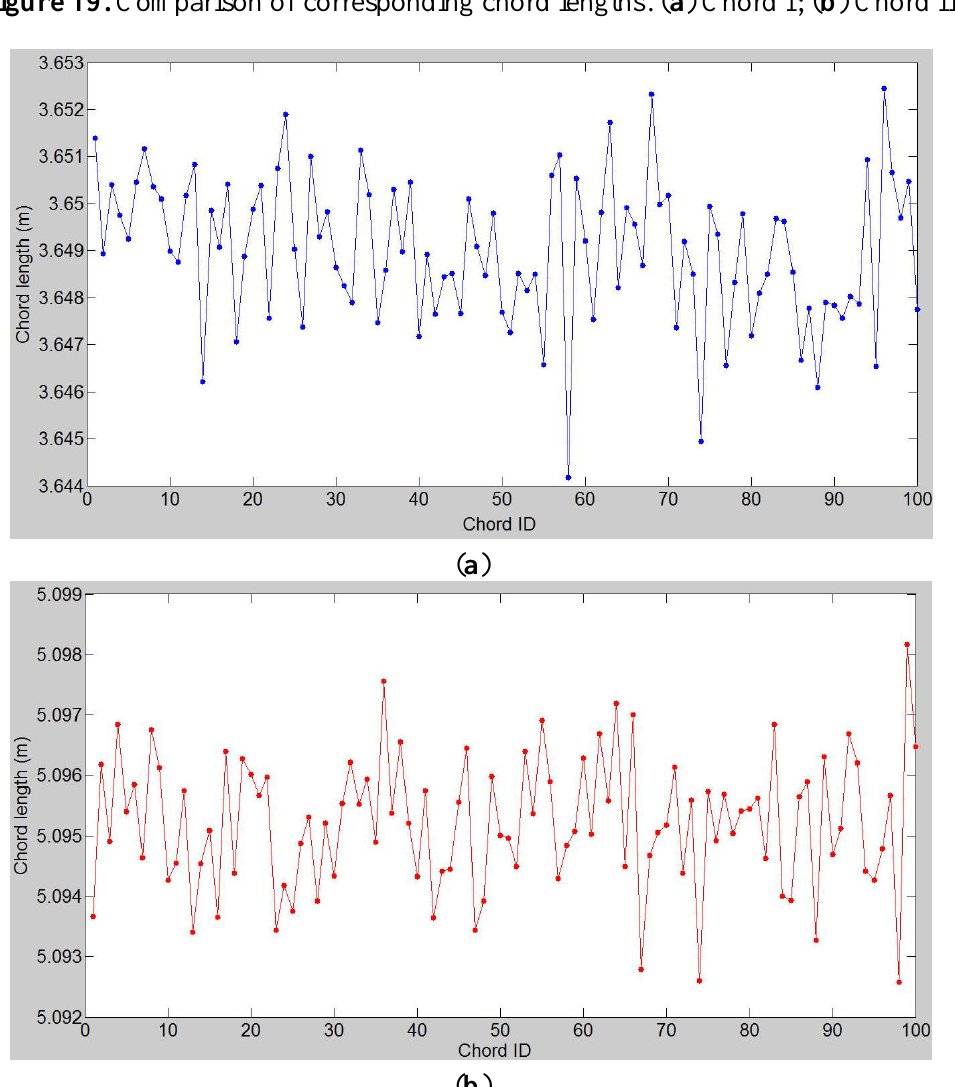
Figure 19. Comparison of corresponding chord lengths. ( a ) Chord I; ( b ) Chord